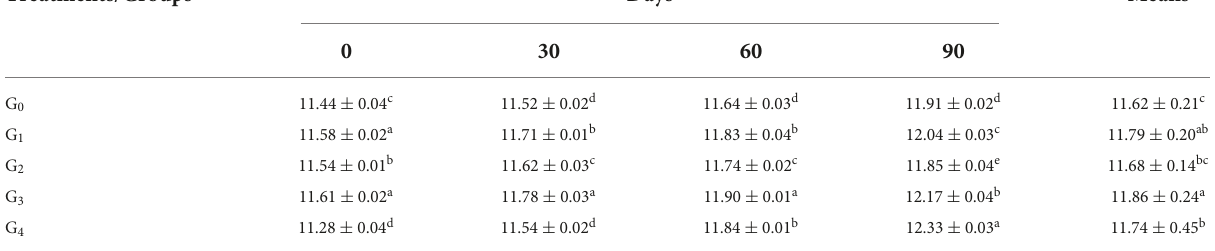
TABLE 3 Effect of fortified diets on hemoglobin levels (mg/dL) among anemic women. Treatments/Groups